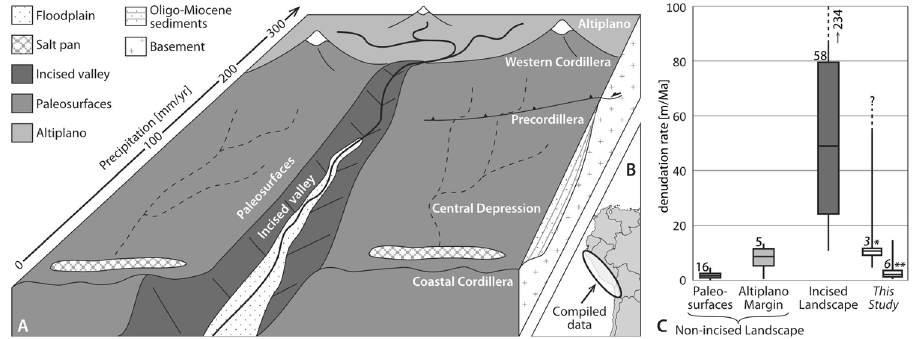
Figure 1. ( A ) Block diagram displaying the main tectono-geomorphic domains of the western escarpment of the central Andes at 15°–22°S. Altiplano: high-elevation, low-relief, non-incised. Western Cordillera: highest volcanic peaks, minimal incision. Precordillera: active W-verging thrust system, moderate incision. Central Depression: preserved non-incised paleosurfaces with ephemeral streams and endorheic drainage, decoupled from the deeply-incised valleys hosting perennial streams. Coastal Cordillera: actively uplifting relict erosional surface. ( B ) Spatial extent of the compiled data set of modern denudation rates 15,16,19,20 , for more details the reader is referred to the supplementary data. ( C ) Boxplot displaying the statistics of the compiled 10 Be-inferred modern denudation rates from the different tectono-geomorphic domains and the mid-Miocene paleo- denudation rates from this study (single asterisk: samples 10.5–11.5 Ma-old; double asterisk: all other samples). The solid vertical lines indicate minimum and maximum values; the lower and upper end of each box indicates the first and the third quartile, respectively; the solid horizontal line indicates the median value; the number next to each box indicates the population. This figure was created using the software Adobe Illustrator ® CS5 (www.adobe.com/products/illustrator.html), licensed to the University of